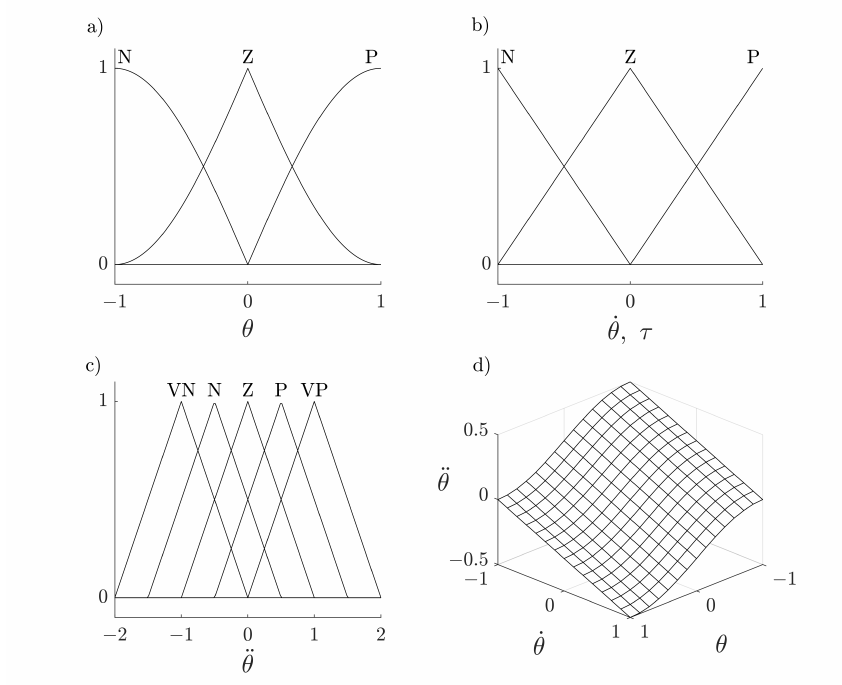
Figure 25. Fuzzy sets; ( a ) input set θ , ( b ) input sets ˙ θ and τ , ( c ) output set ¨ θ centre of gravity and ( d ) output surface between ¨ θ , ˙ θ and θ .